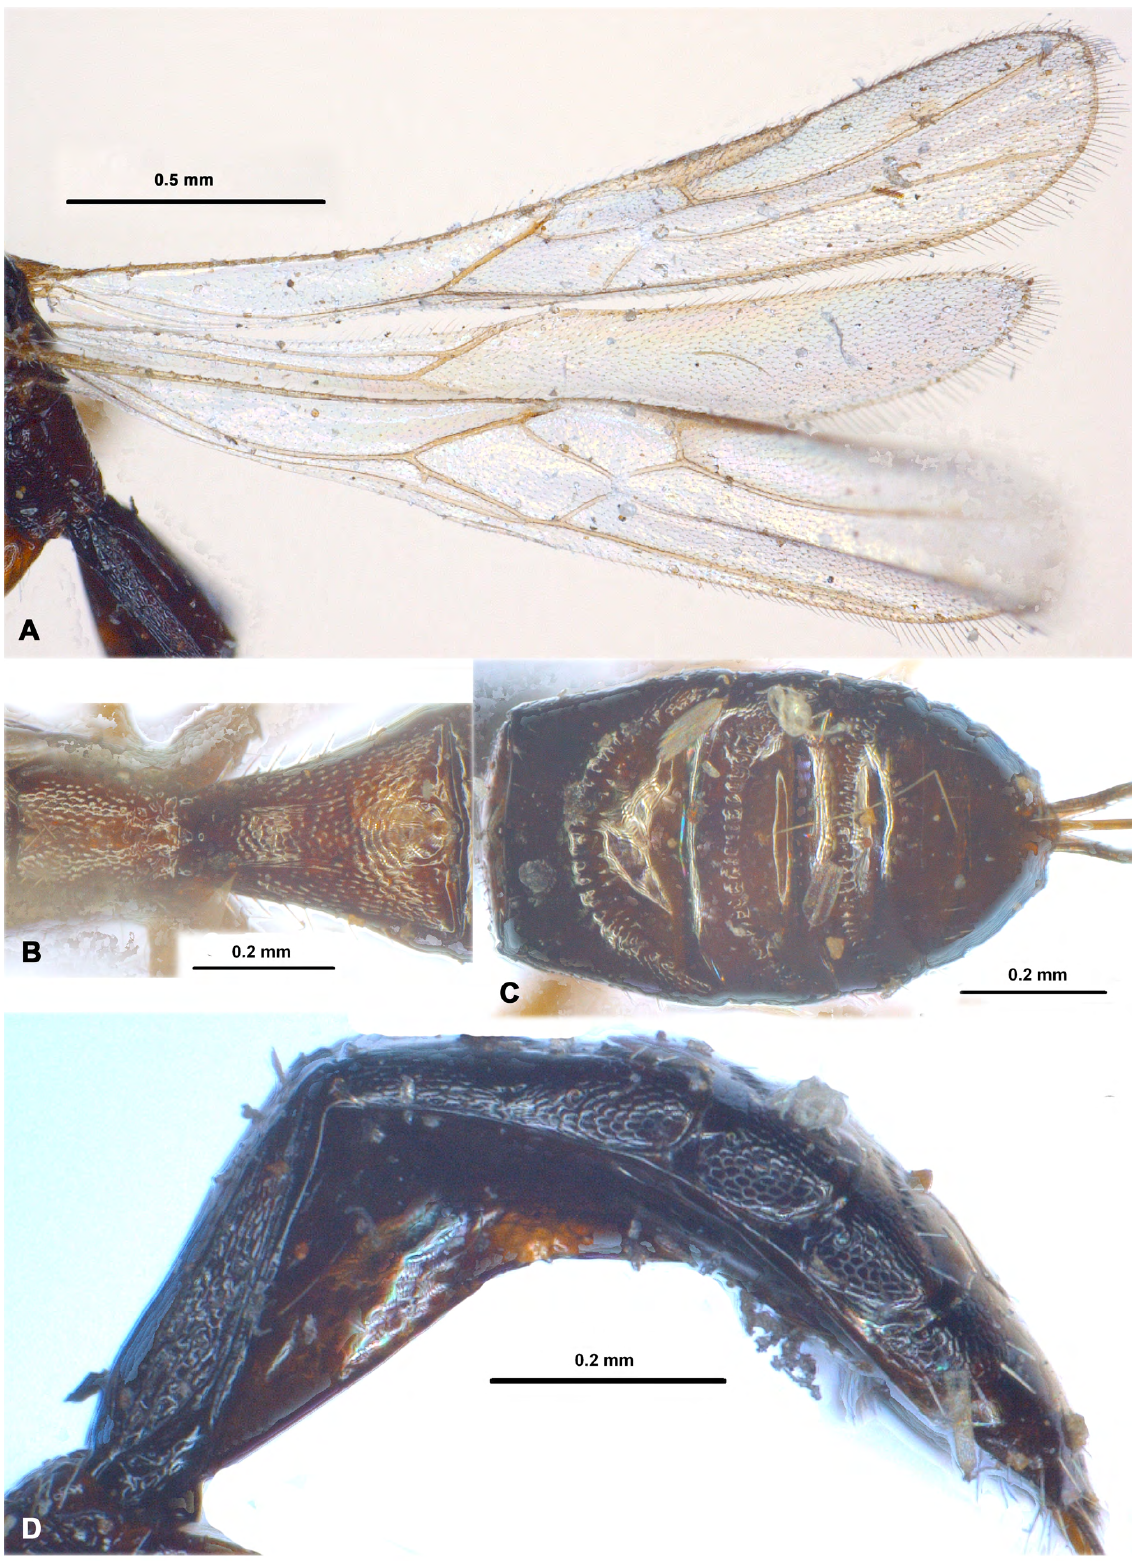
Fig. 13. Grangerdoryctes niger (Granger, 1949), ♀, holotype, MNHN. A . Wings. B . Propodeum and first metasomal, dorsal view. C . Metasoma (without first tergite), dorsal view. D . Metasoma, lateral